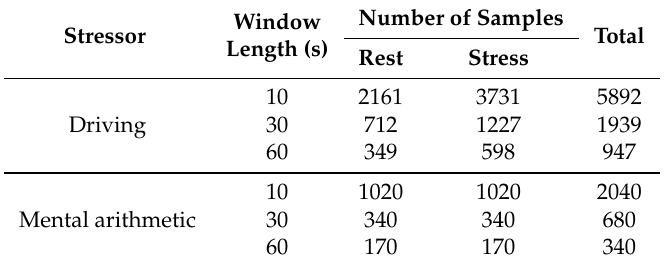
Table 2. Number of samples in the data